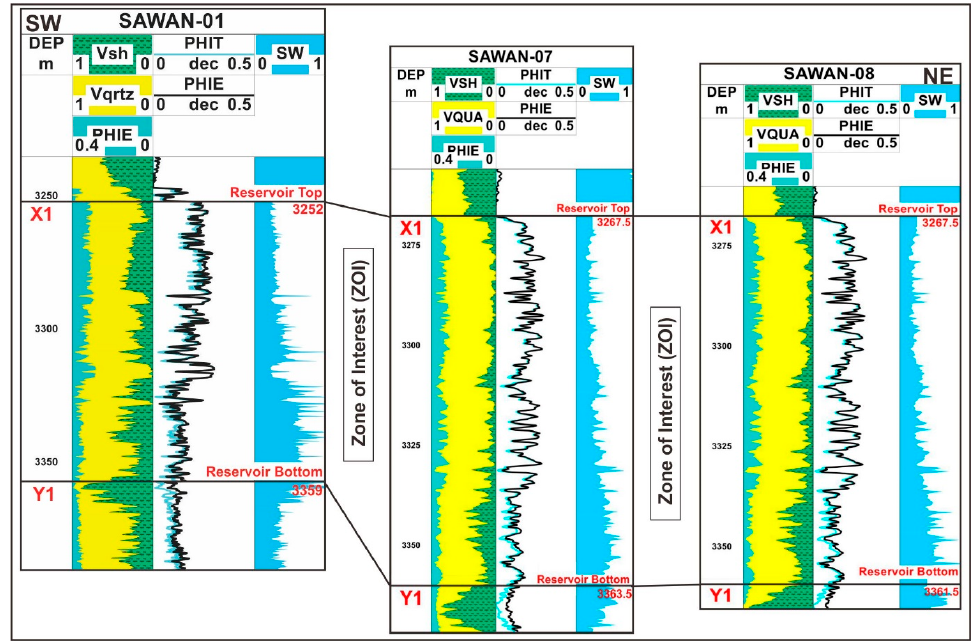
Figure 6. The structural configuration of study wells highlighting the thicknesses of the reservoir parameters within the